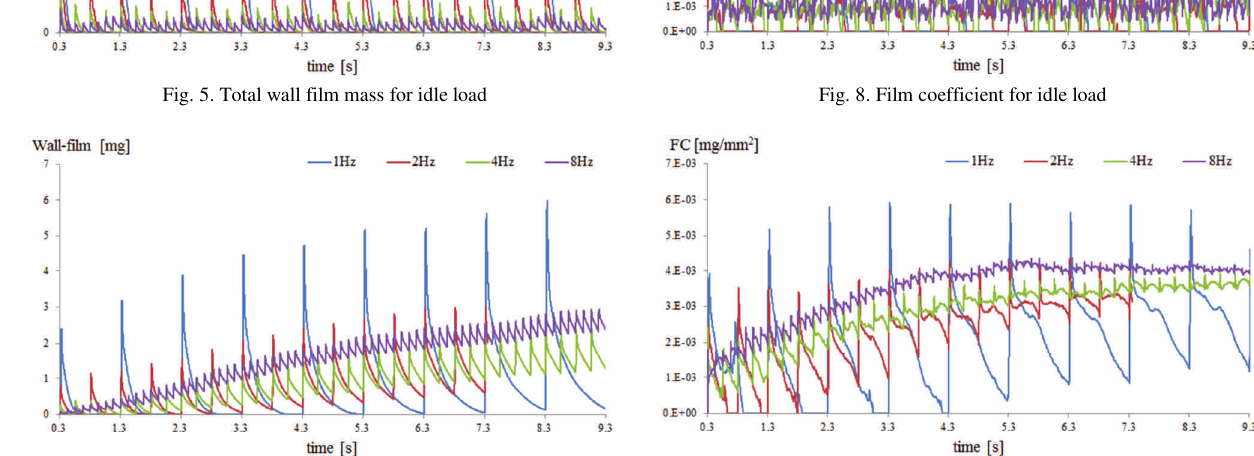
Fig. 8. Film coefficient for idle load